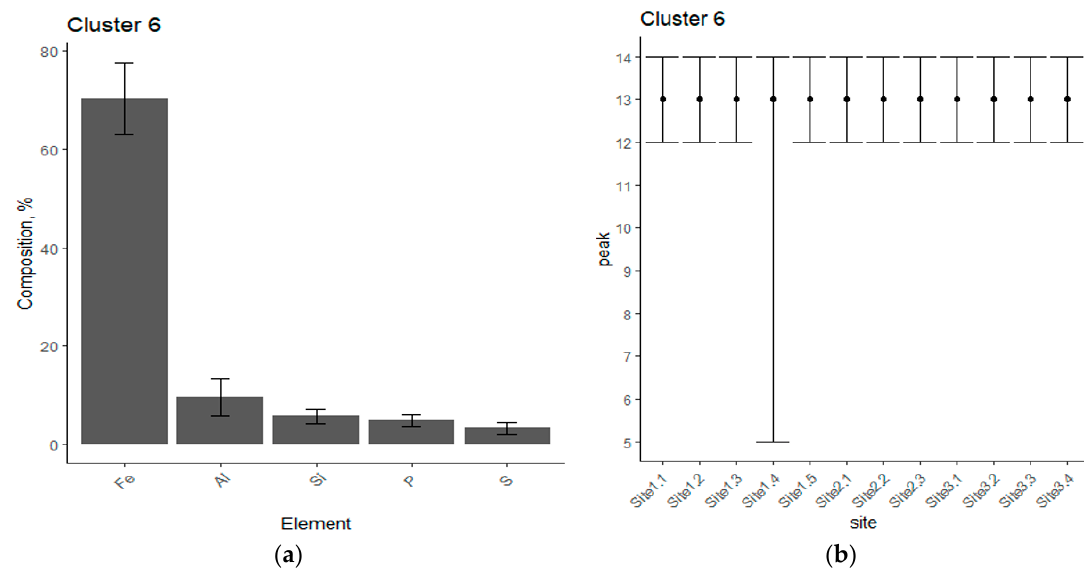
Figure 9. ( a ) Standard deviation and average chemical composition of the components in cluster 6; ( b ) extraction peak location and their windows of extraction for cluster 6 components.